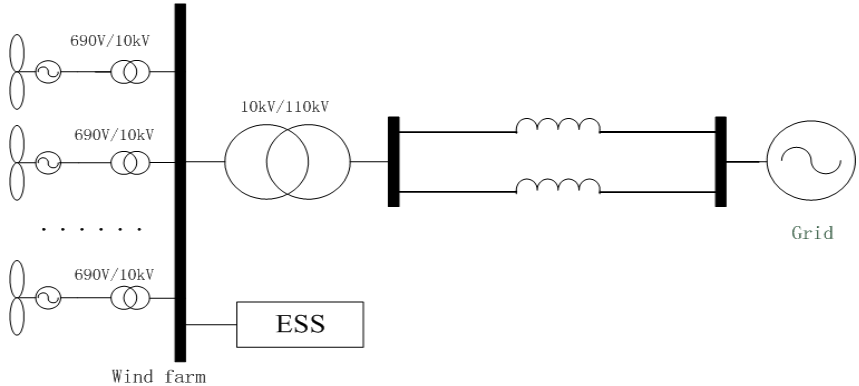
Figure 1. Wind power system with